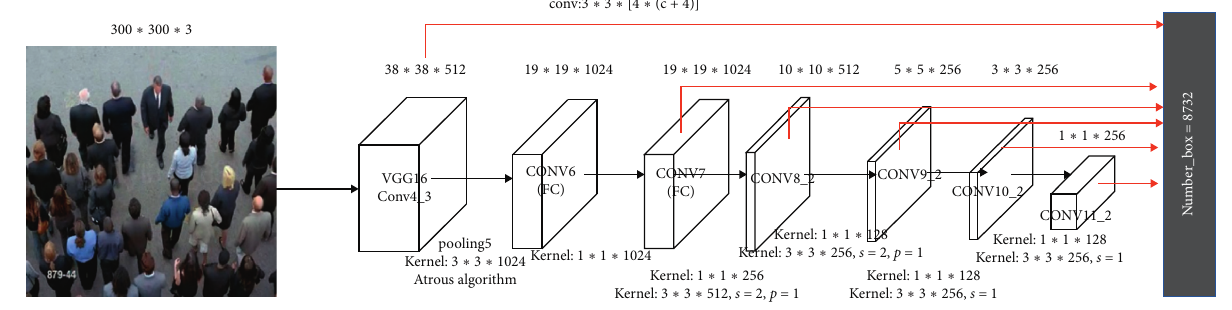
Figure 7: SSD network